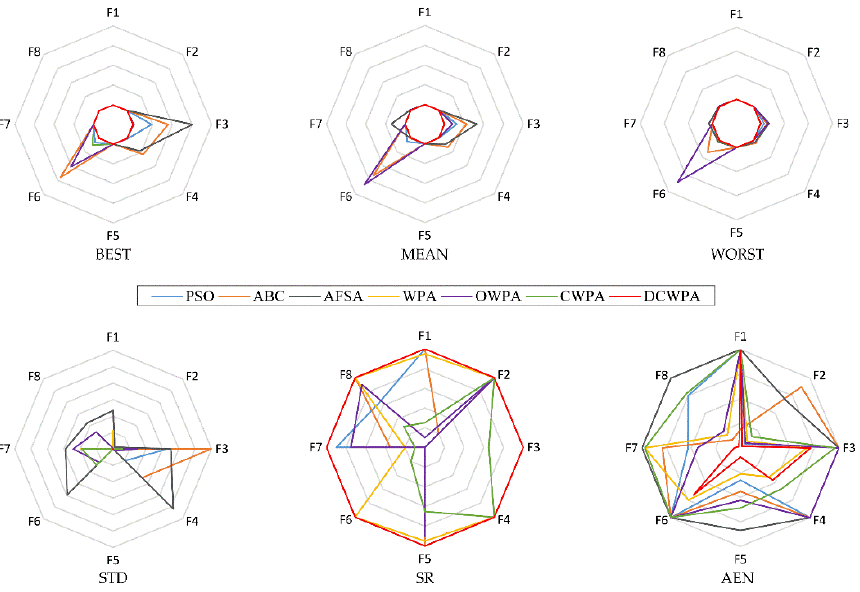
Figure 11. Algorithm level radar chart.